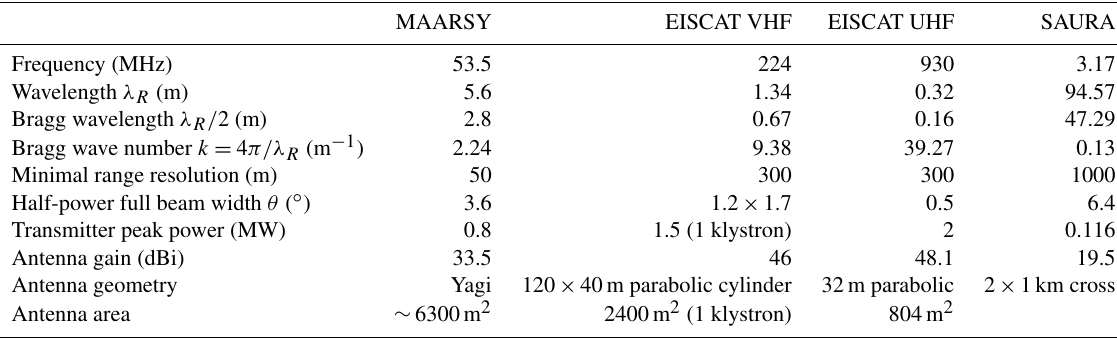
Table 1. Radar system parameters.